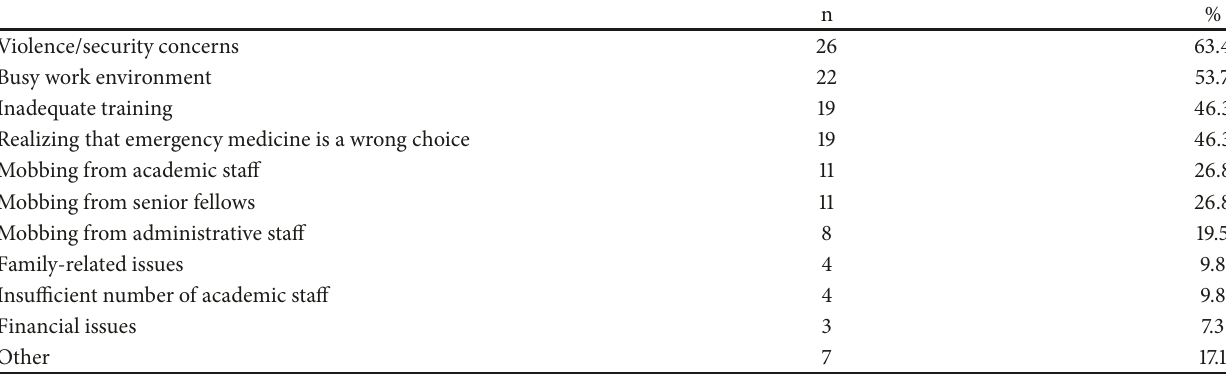
Table 3: Causes of resignation from